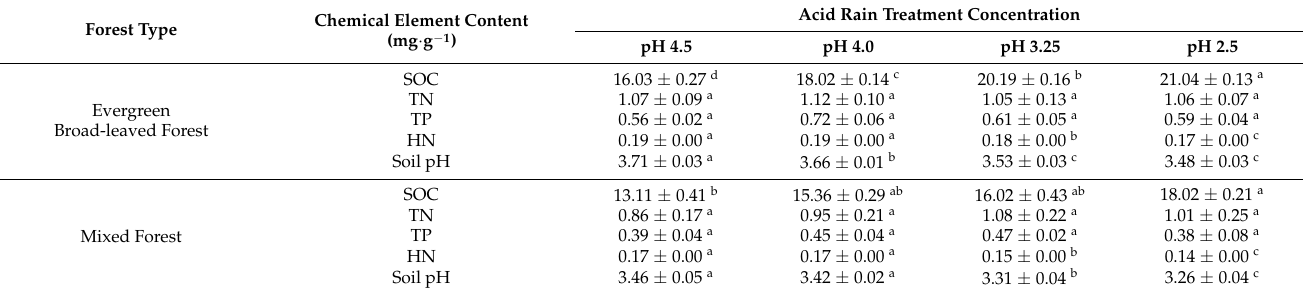
Table 1. Soil chemical properties under different acid rain treatments in January. Forest